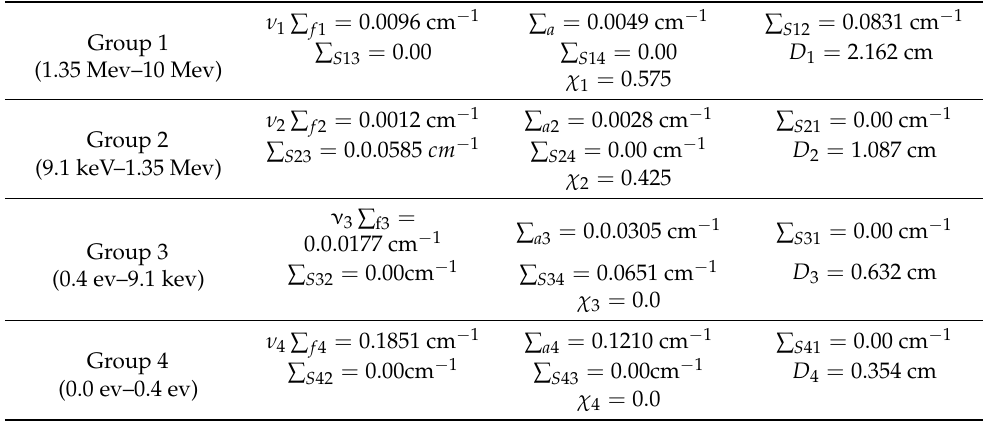
Table 15. Four-group reflected reactor cross-sections data.